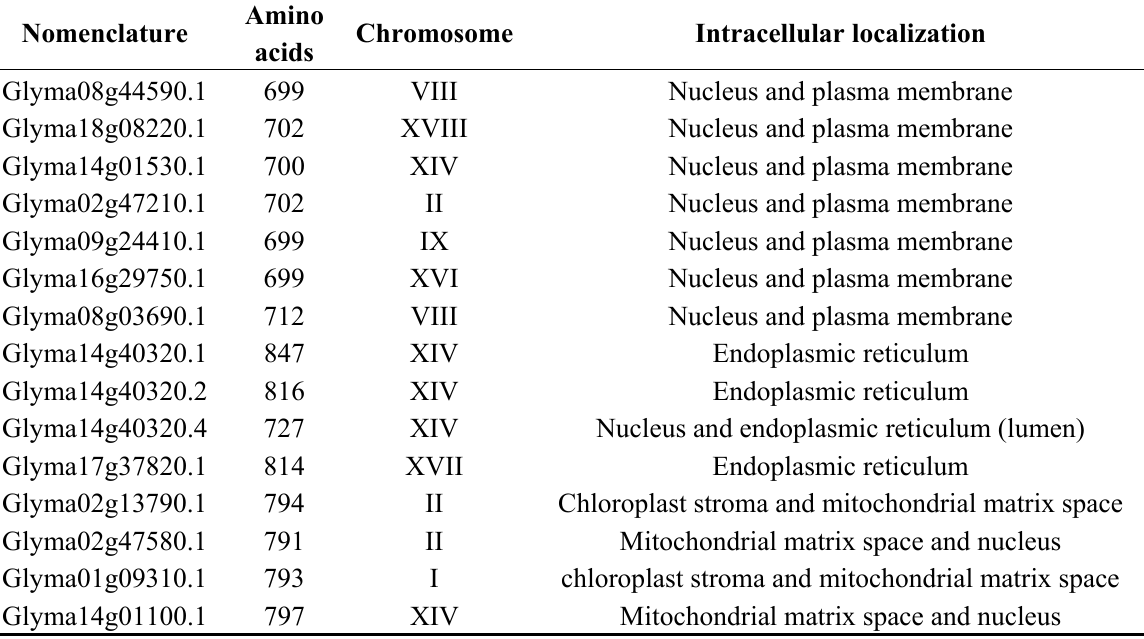
Table 3. Glycine max Hsp90 proteins.